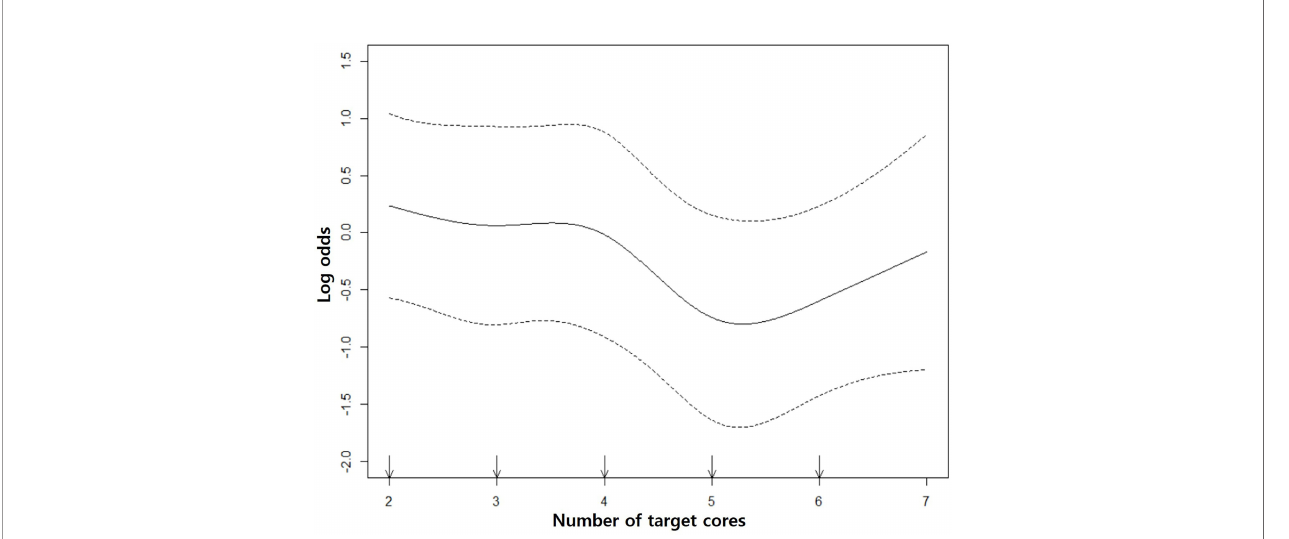
FIGURE 3 | Restricted cubic spline curves. The middle solid curve shows the change of GS upgrade according to the number of target cores. It decreases from the 5th core and there is no signi fi cant GS change between 5th and 6th cores. The upper and lower dotted curves indicate the upper and lower limits of log